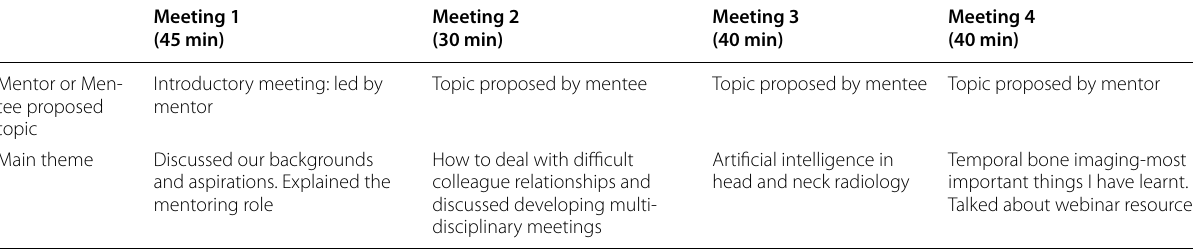
Table 6 Sample mentoring meeting discussion